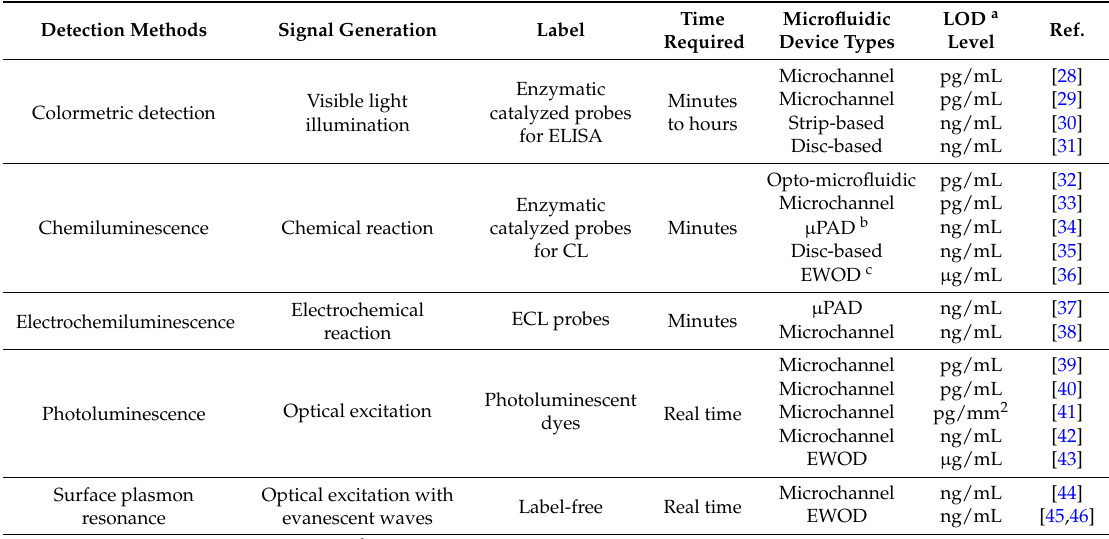
Table 1. Comparison of various optical microfluidic immunosensing